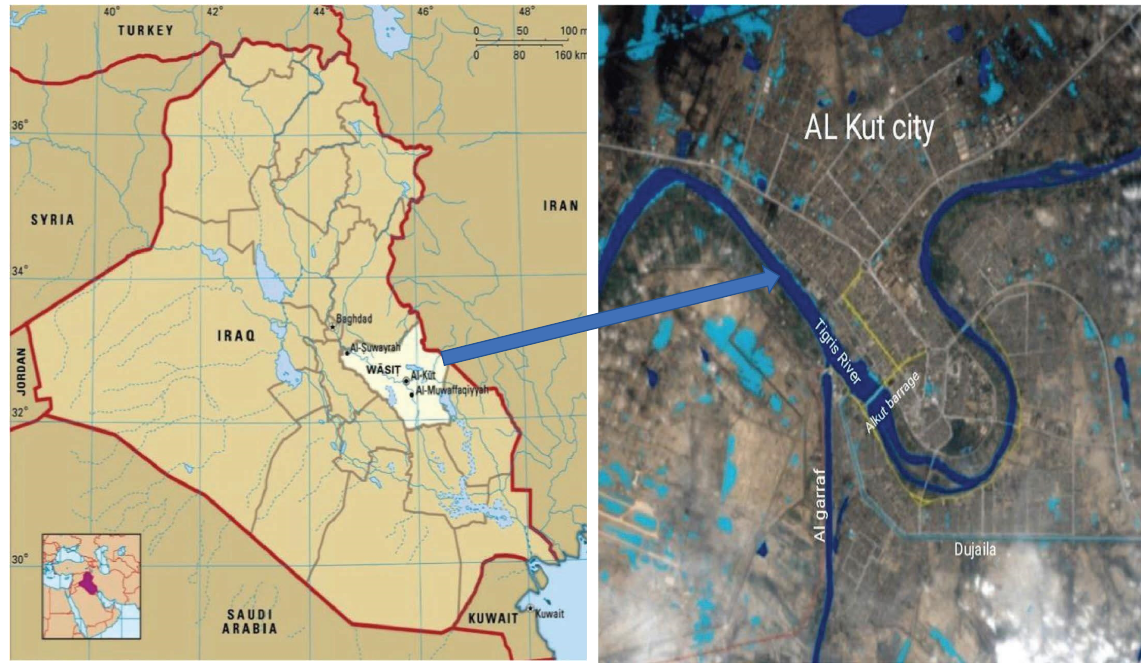
Figure 1: Location of case study, AL-Kut City, Tigris River, Iraq.